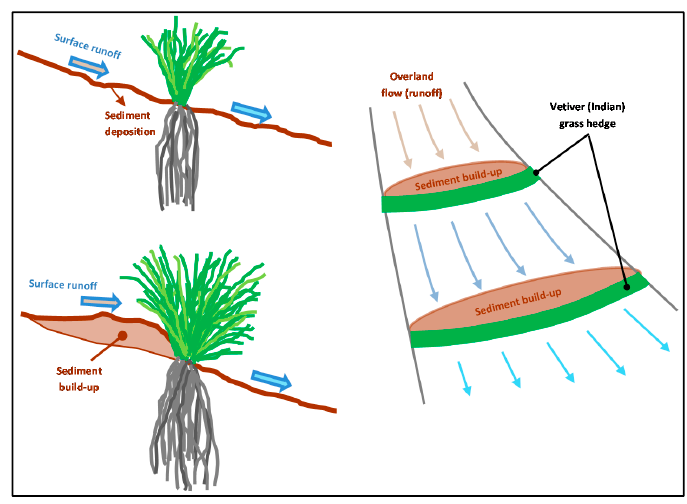
Figure 1. Schematic of the role of Vetiver grass in filtering sediment carried in overland flow. Table 1. Existing literature overview of experimental studies applying Indian grass.